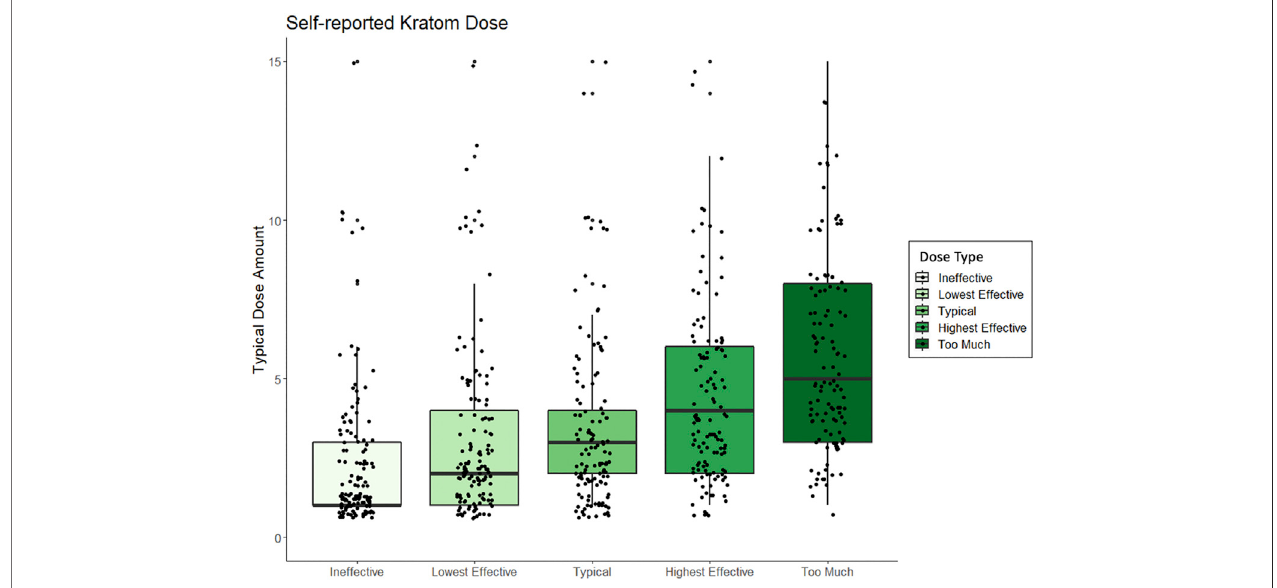
FIGURE 2 | Box and whisker plots displaying peoples self-reported kratom doses, standardized across method of kratom consumption, and which range from amounts that people perceived to be “ ineffective ” to what dose they perceived to be “ too much. ”